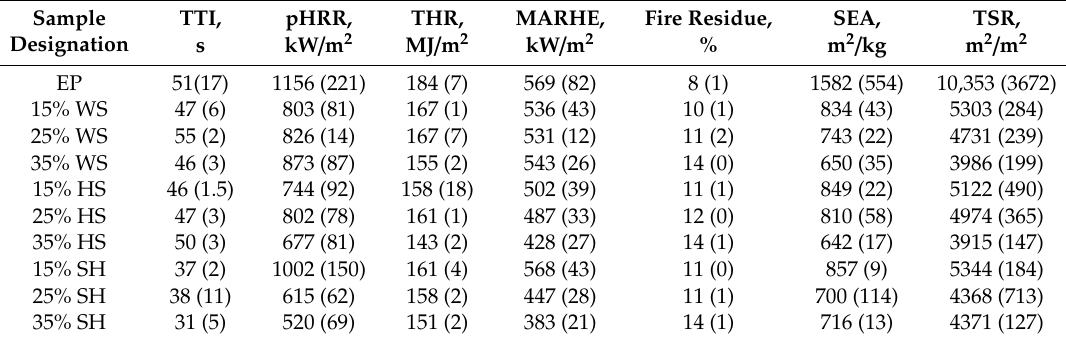
Table 3. Cone calorimeter results of epoxy composites modified with shell and husk (standard deviation).